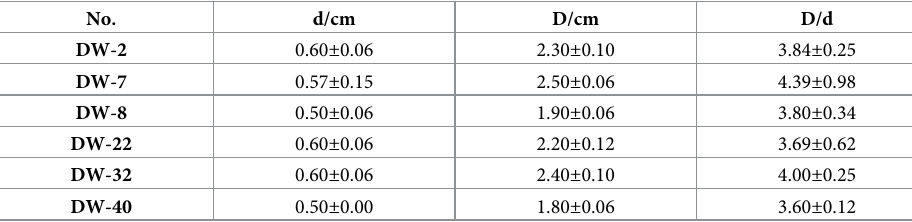
Table 1. Diameter of transparent ring and strain diameter